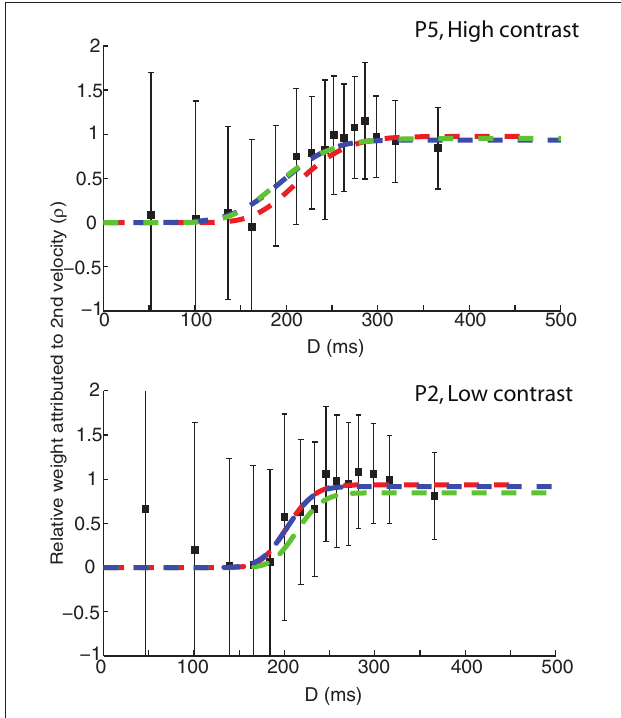
Figure 6 | Comparison of the weighting function fits based on the original gamma model (green), the simplified gamma model (red), and a gaussian (blue). The top panel shows the participant data set with the highest correlation between the model fits (P5).The bottom panel shows the participant data set with the lowest correlation between the model